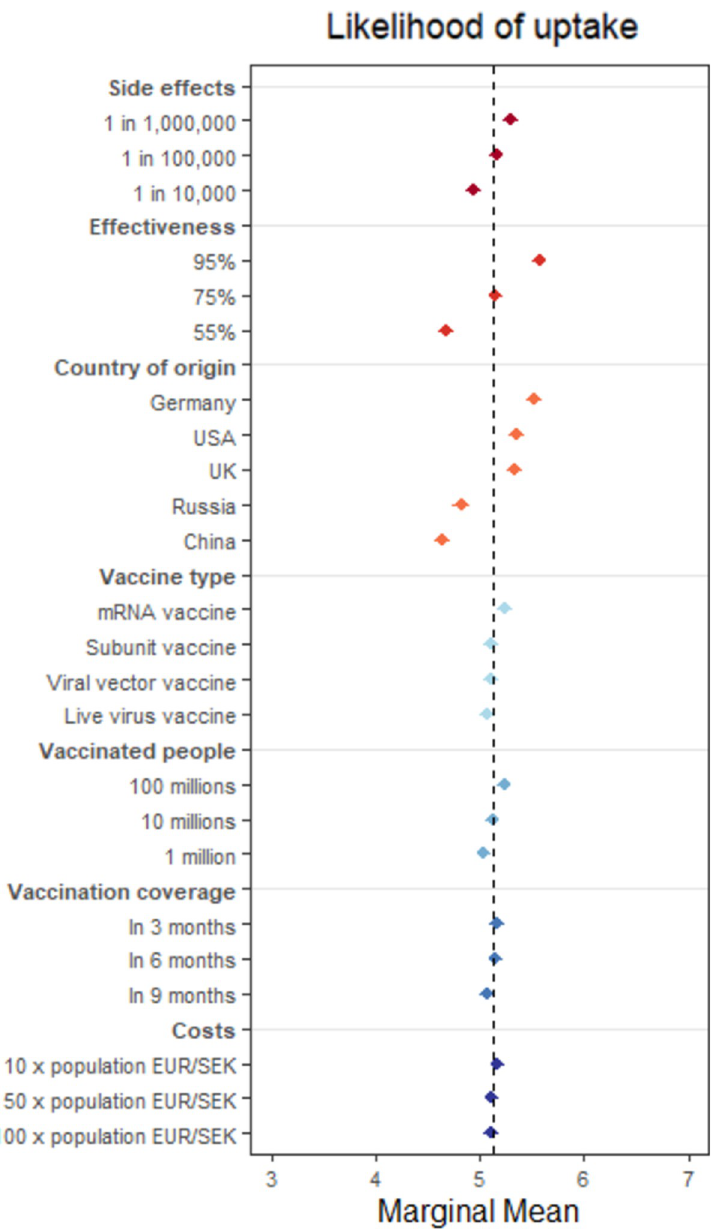
Fig 2. MMs for self-reported likelihood of uptake. The figure reports the marginal mean point estimates are plotted with 95% CIs, representing the average likelihood of uptake at each vaccine attribute level. The dashed line represents the grand mean